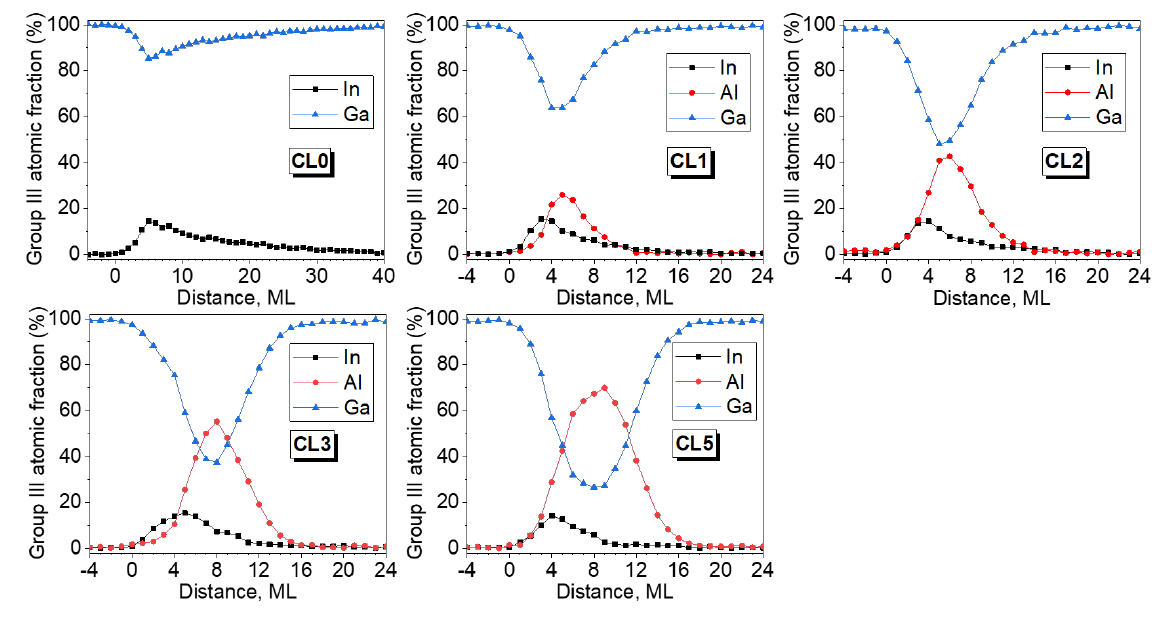
Figure 6. Compositional profiles at ML resolution level for elements of the III group along the growth direction for the WL region in the different AlAs/InAs QD layers.